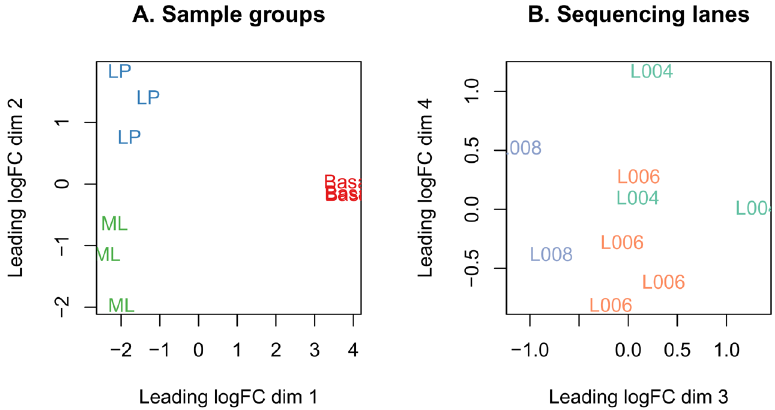
-fold-change for the 500 genes 2